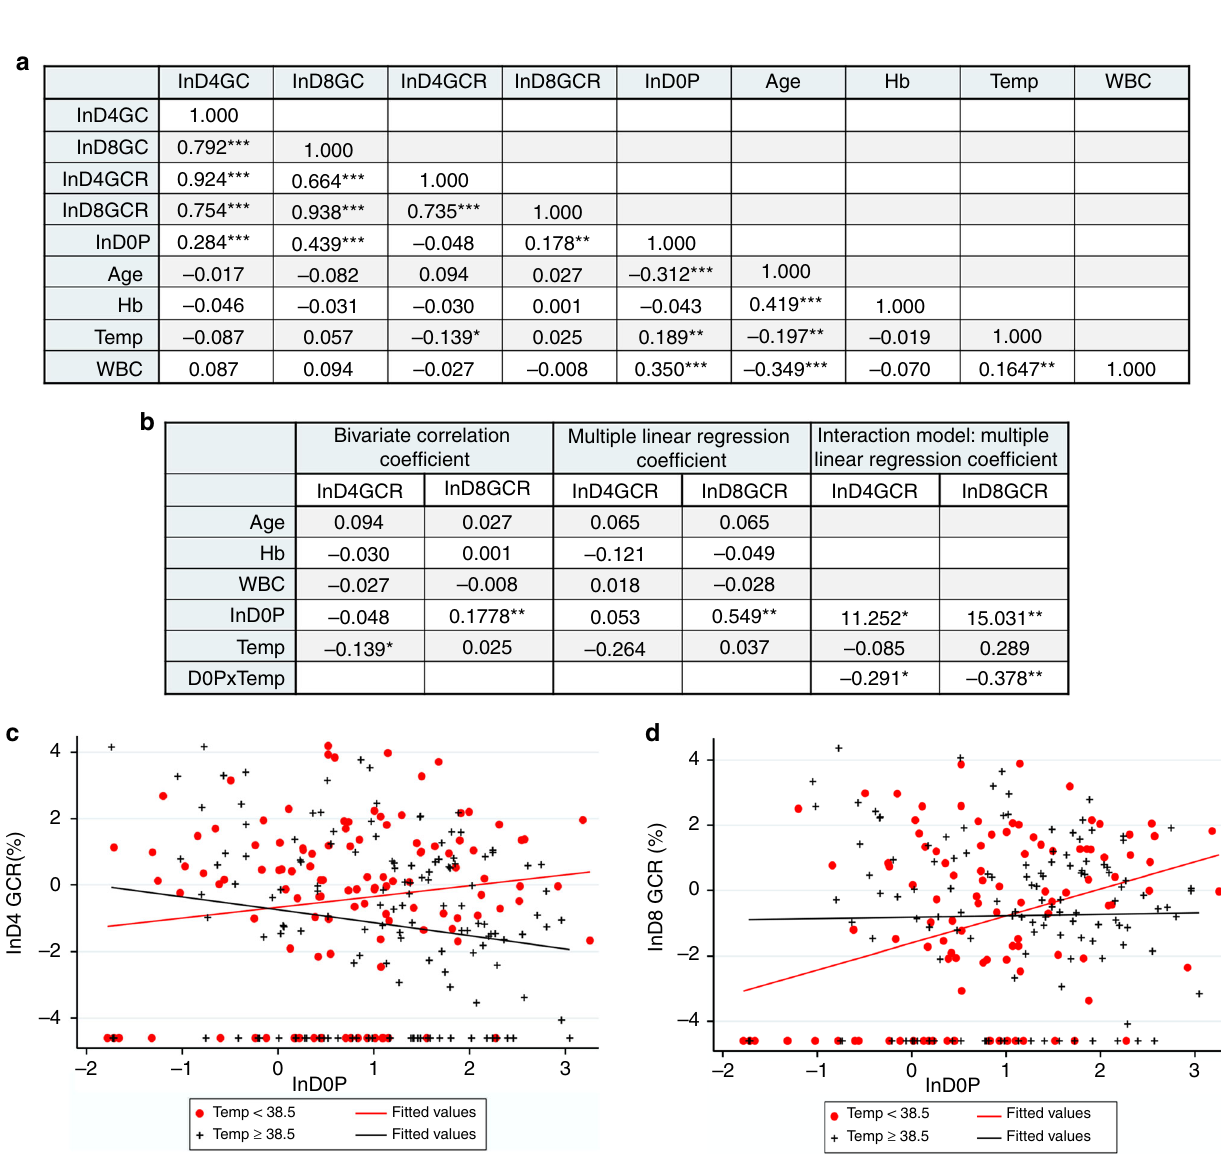
Fig. 2 Final model of the in fl uence of D0 parasitemia and fever on gametocyte conversion. a Pearson correlation of the subject ’ s gametocyte production, D4 and D8 gametocytemia (GC), GCR, and clinical characteristics, D0 parasitemia (D0P), hemoglobin concentration (Hb), temperature (Temp) and white blood cell count (WBC). The D0P and D4 and D8 GC and GCR were normalized by natural log transformation (ln) prior to statistical analysis. The Pearson correlation coef fi cient is shown and probability is indicated by p ≤ 0.05 (*), p ≤ 0.01 (**), p ≤ 0.001 (***). b Summary of the statistical tests used to evaluate the association of D4 and D8 GCR with clinical parameters. The complete table for the bivariate correlation is shown in a , the multiple linear regression is in Supplementary Table 2 and the interaction model is in Supplementary Table 3. The coef fi cients are shown with asterisks indicating p values as described for a . c , d Graphical representation of the negative in fl uence of temperature on the positive relationship between the D0P and GCR. The natural log of the D4 ( n = 260) or D8 ( n = 238) GCR are plotted against the natural log of the D0 parasitemia (D0P). Data and trend lines from subjects with temperatures < 38.5 °C (the median D0 temperature) are shown in red dots and ≥ 38.5 °C are shown in black